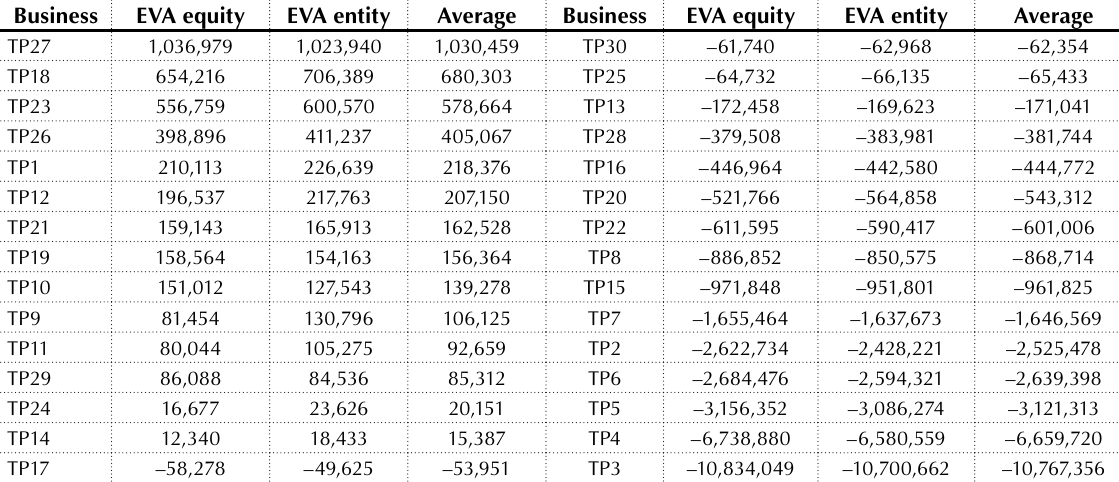
Table 1. Values of EVA equity and EVA entity